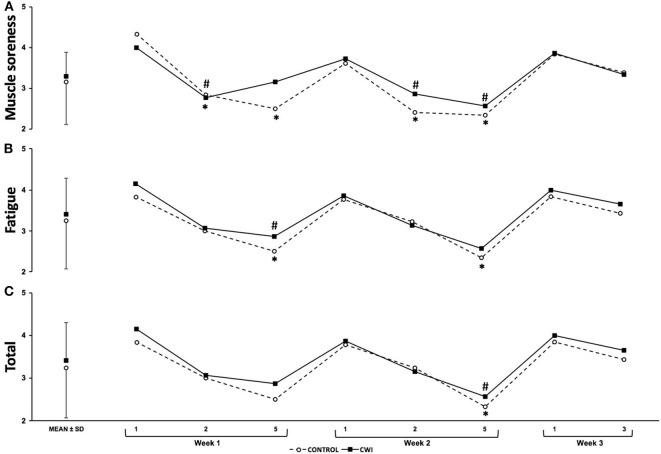
Mean ± SD wellness scores at different time points for CWI and Control groups. (A) Soreness; (B) Fatigue; (C) Total *Significant difference (p < 0.05) from baseline in the Control group. #Significant difference (p < 0.05) from baseline in the CWI group.